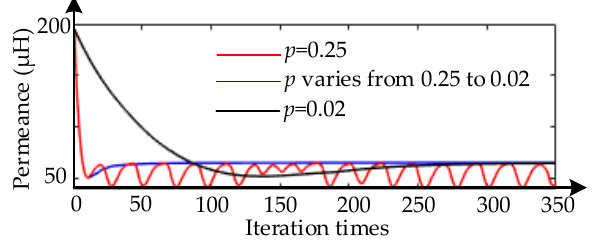
Figure 7. Permeance of rotor tooth with different damping factors.